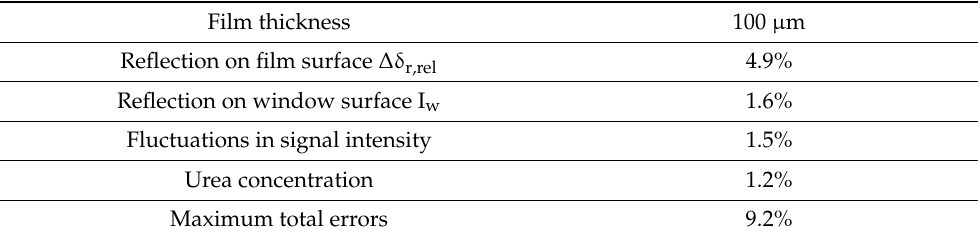
Table 2. Overview of all quantified errors.